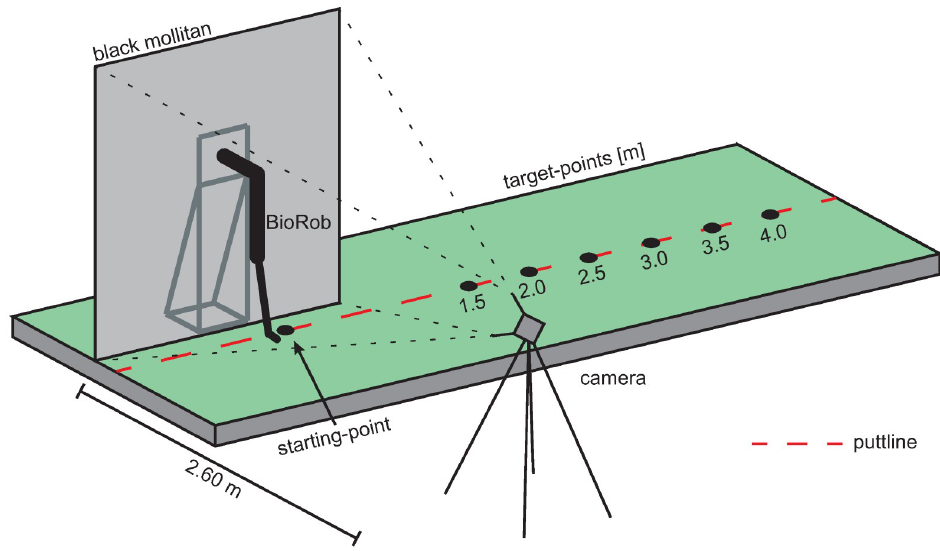
Fig 3. Video recording setup. Schematic representation of technical arrangement for the recording of the video material.